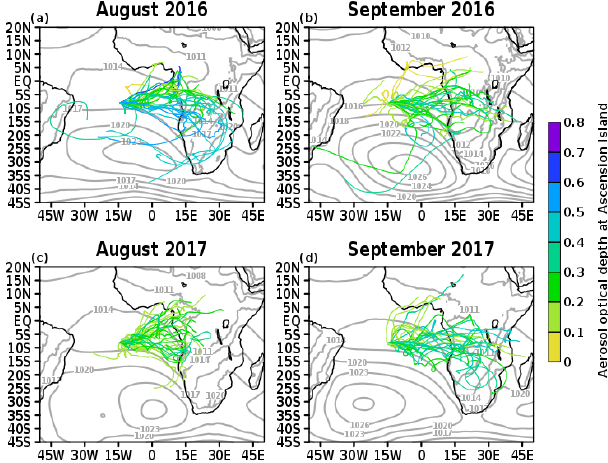
Figure 4. Trajectories of a parcel originating at 2km over Ascen- sion Island extending backward for 10d, color-coded based on the AOD on the start date for (a) August 2016, (b) September 2016, (c) August 2017, and (d) September 2017. Gray contours indicate monthly mean sea level